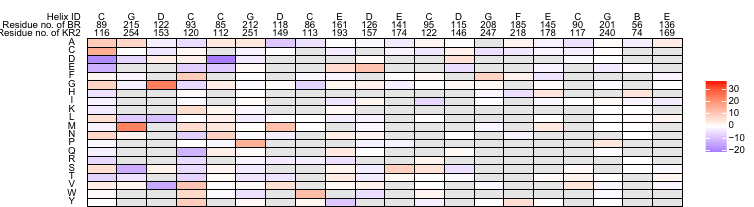
Figure 5. Coefficient parameters of the fitted statistical model. Coefficients for the top 20 active residues, where ,2 . Here, red and blue indicate that the iM the activeness of each residue is defined as β = ∑ = … = s j N : , 1, , j i j 1 corresponding parameters are positive and negative, respectively, whereas grey indicates that the amino-acid species did not exist in the training data. The figure can be interpreted such that, if the value of a coefficient parameter β i , j is positive/negative (i.e. red/blue), then the existence of the i -th amino-acid species at the j -th residue has a red-shifting/blue-shifting